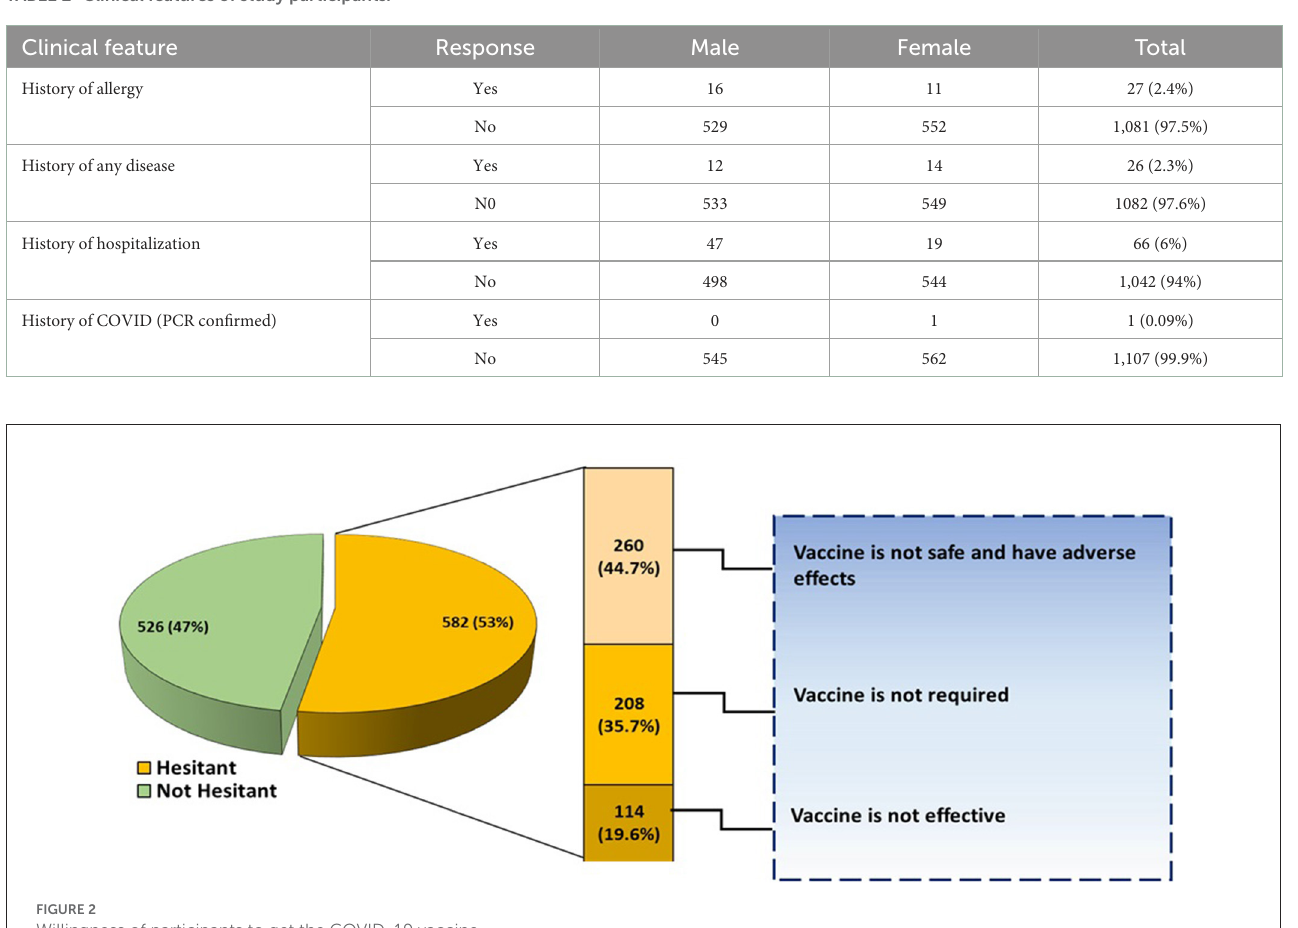
TABLE 2 Clinical features of study participants.